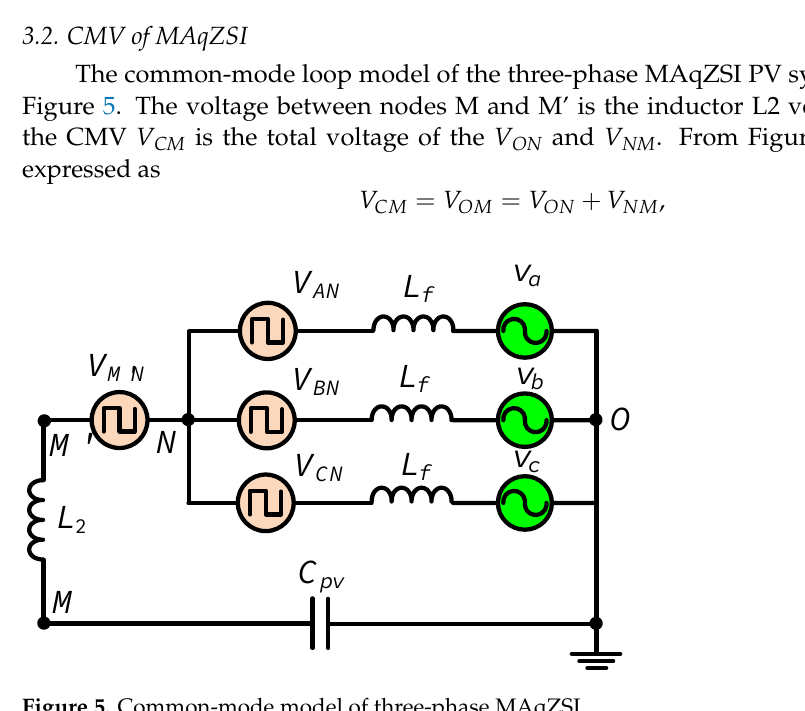
Figure 5. Common-mode model of three-phase